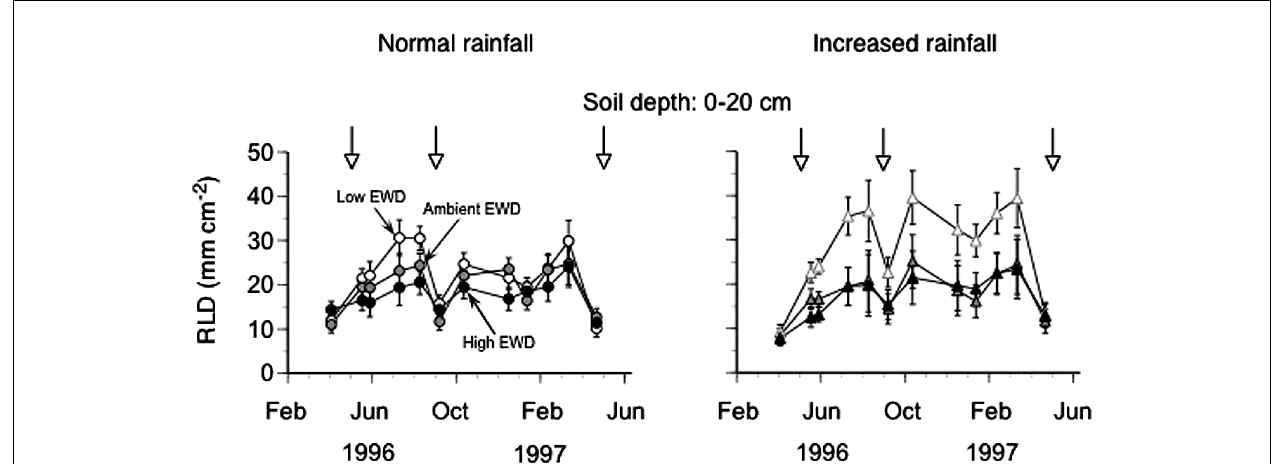
FIGURE 1 | Seasonal dynamics of root length density (RLD) measured using minirhizotrons (0–20 cm topsoil, one 60 cm long tube per plot) in trenched grassland plots with manipulated earthworm densities (EWDs) under ambient and increased rainfall (means ± SEs, n = 5 plots per